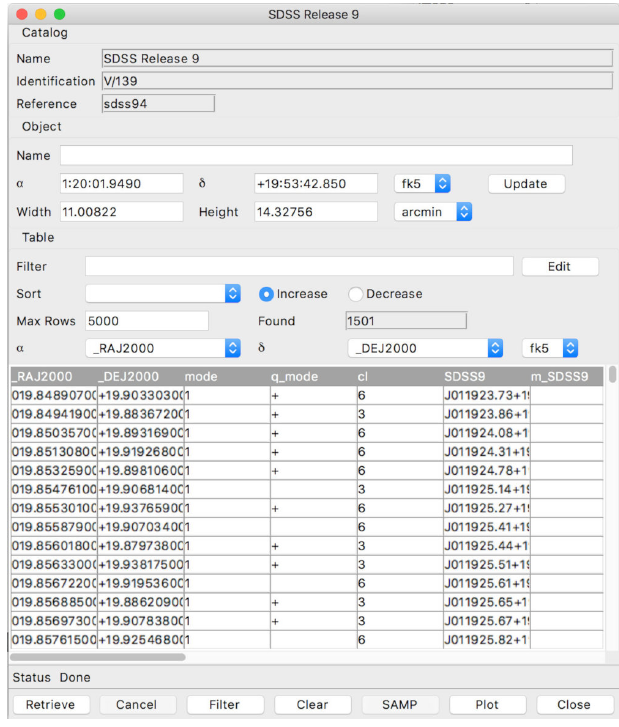
Fig. 43.— Catalog window for the SDSS DR9 stars within our window is a list of objects. Each object corresponds to one of the green circles in the image. Use the scroll bar to look at the list’s different columns, and you will see that, in addition to the object’s position (RA and Dec), there is information about the object’s brightness: the different apparent magnitudes, as measured using the SDSS filter set ugriz , corresponding to specific filters centered in the near-UV (u filter, magnitude is given in the umag col- umn), the blue-green part of the spectrum (gmag), the red region (rmag), the border region between red and near-infrared (imag) and an infrared filter beyond that